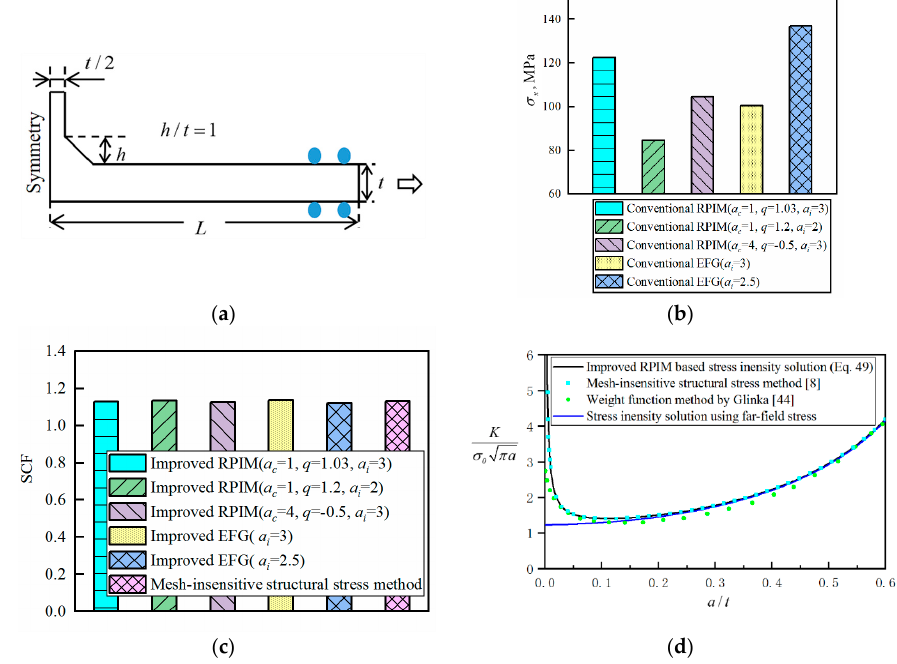
Figure 11. SCFs and notch stress intensities results of T-butt welded joint: ( a ) model definition; ( b ) stress solutions obtained from conventional RPIM; ( c ) results of SCFs based on solutions from improved RPIM and improved EFG; ( d ) validations of notch stress intensities results based on improved RPIM and improved EFG (the improved RPIM-based K was obtained from Equation